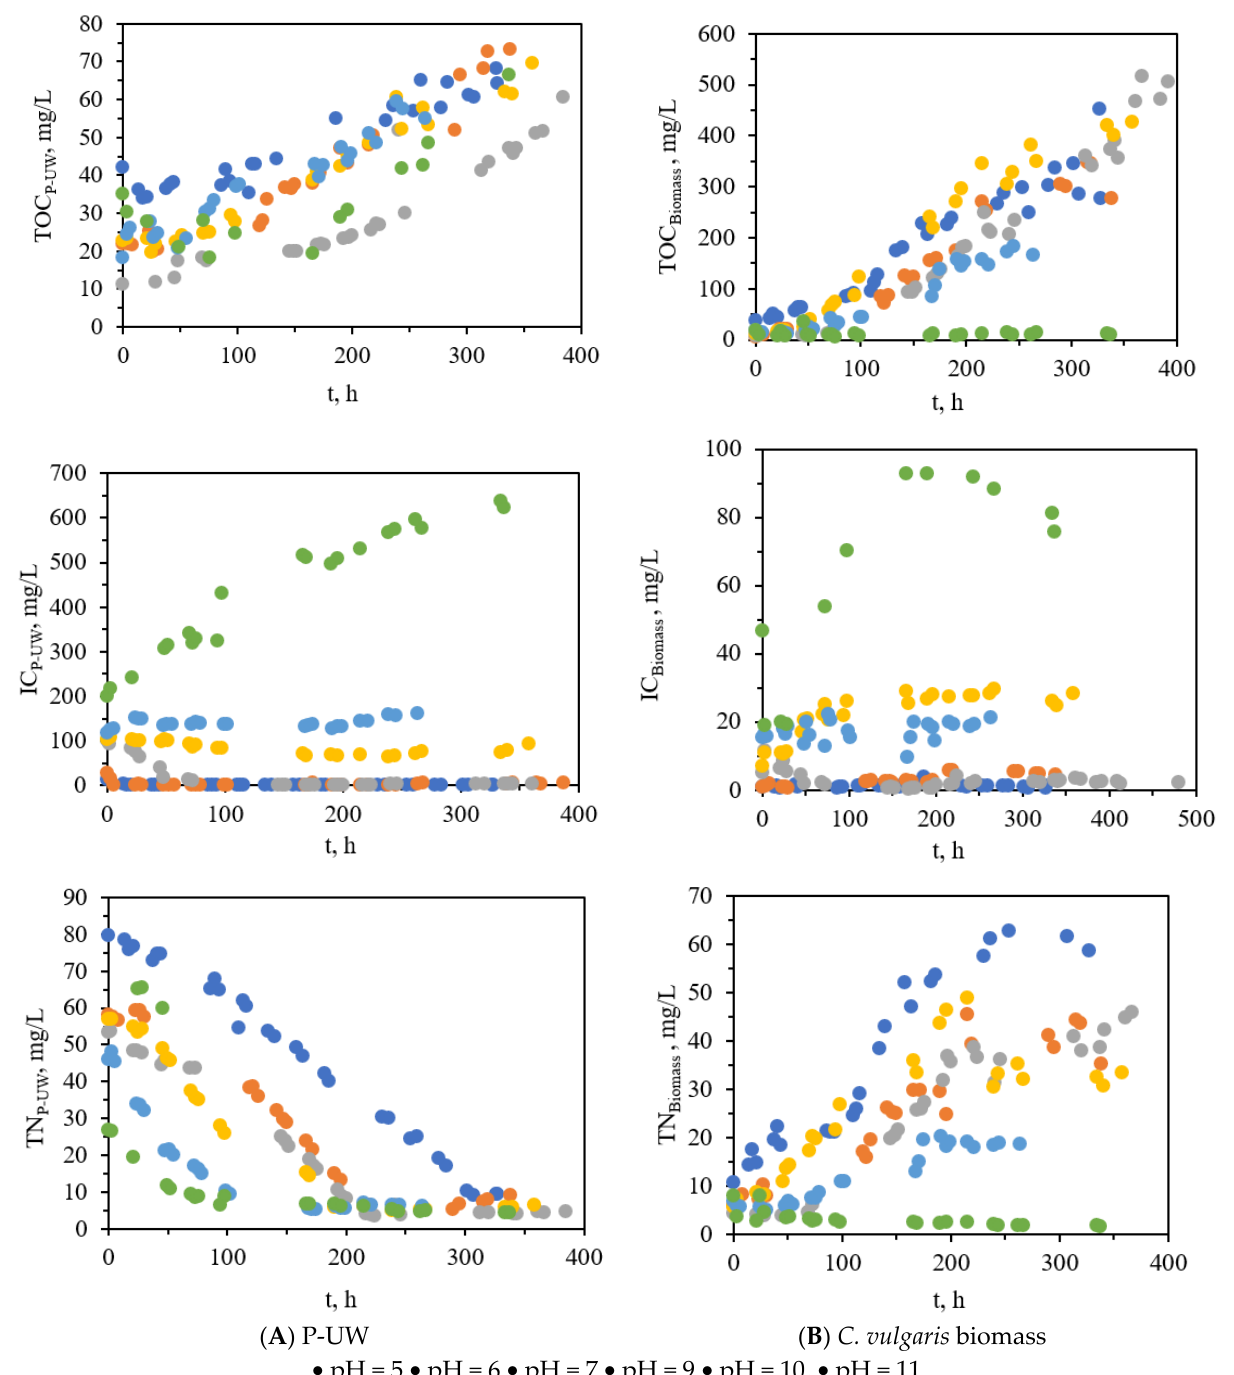
Figure 4. Carbon and nitrogen species behavior in the C. vulgaris cultures at different pH values. ( A ) Carbon and nitrogen species behavior in the treated P-UW (without microalgae) and ( B ) in C. vulgaris biomass produced in cultures. Operating conditions: pH = 7, agitation rate = 200 rpm, aeration rate = 0.5 L/min, T = 25 °C and artificial illumination at 395 E cm − 2 s − 1 . Note: The values presented correspond to mean values of at least three samples with a coefficient of variation (CV = standard deviation*100/mean) of less than 2%.